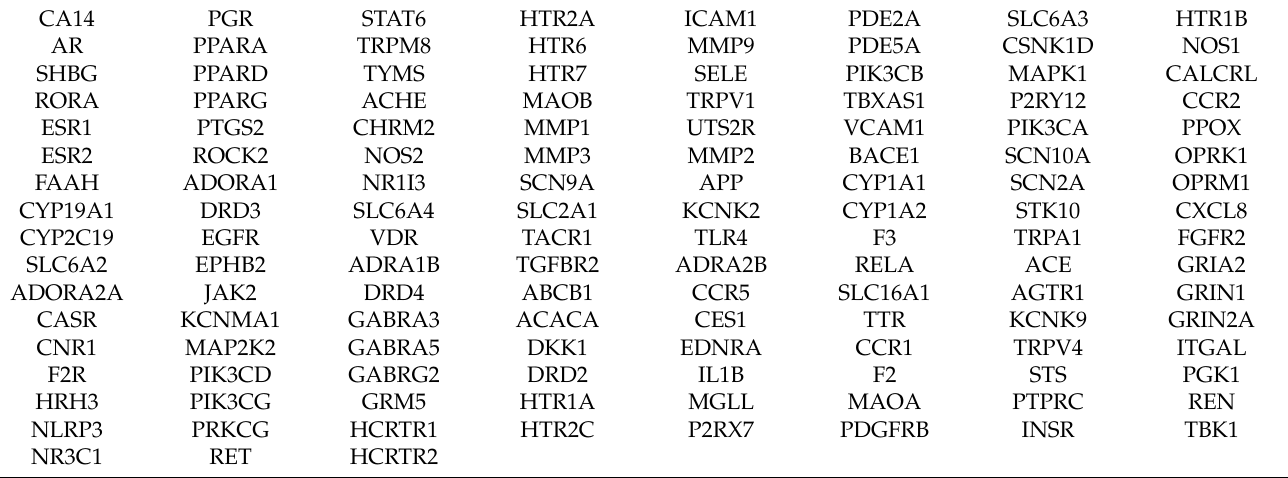
Table 2. The overlapping targets between ALHP and migraines.